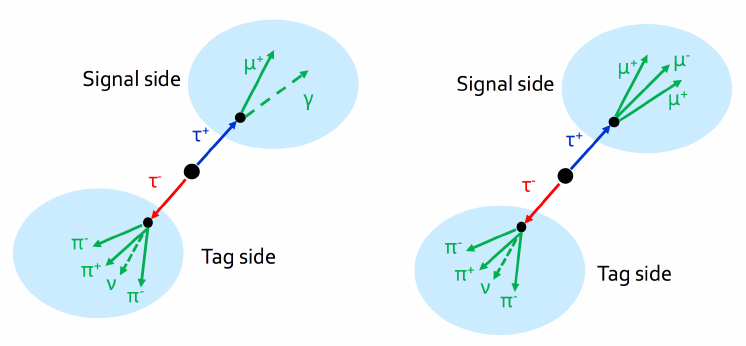
Figure 4: Illustration of the search for lepton flavour violating τ